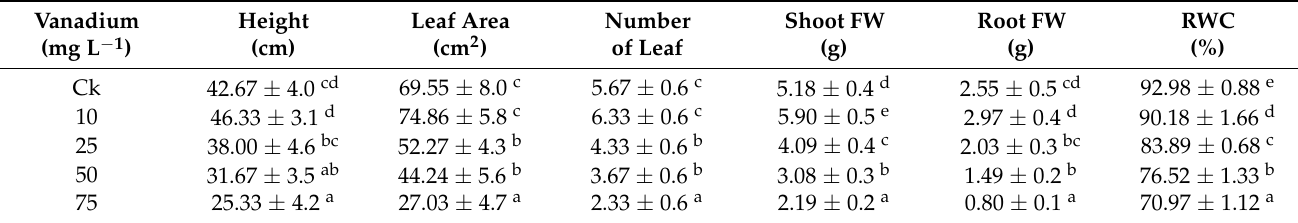
Table 1. The influence of various V treatments on growth parameters of sweet potato.